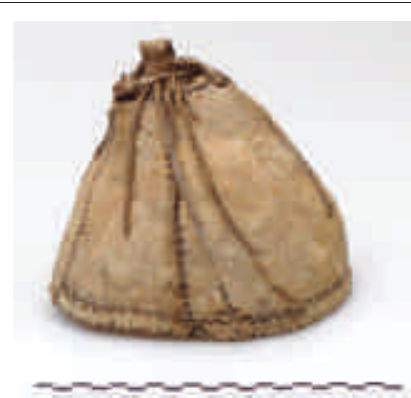
Figure 7 Fur hat (fur facing inwards) with tassel from the Grünerwerk site